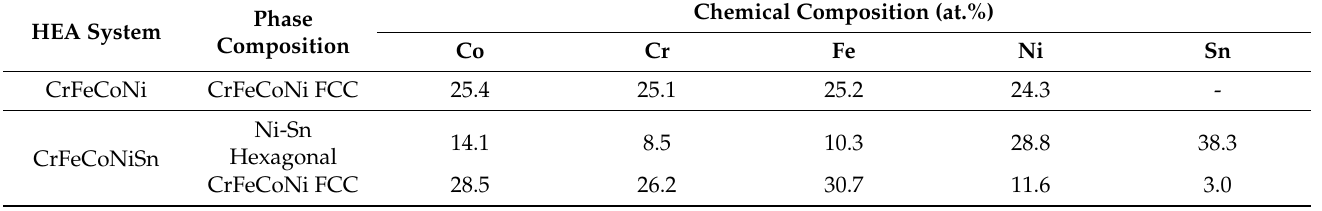
Table 1. The chemical compositions in atomic percent (at.%) of CrFeCoNi and CrFeCoNiSn alloys via EDS analysis determined here, and the phase composition (phase composition identification from previous research [17]). HEA System